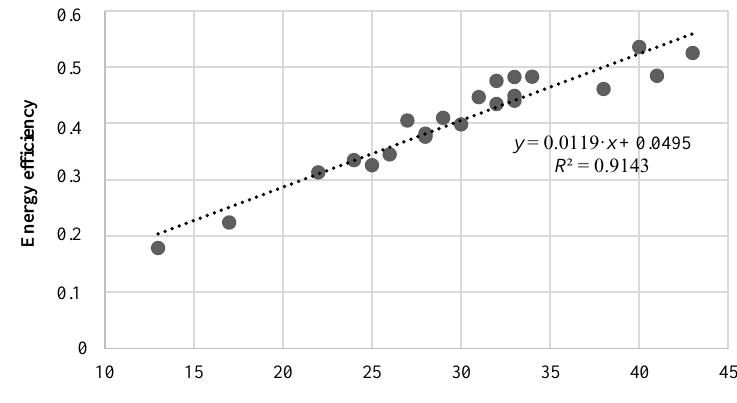
Fig. 8. Two-stage compressor refrigeration system exergy efficiency depending on ambient temperature and refrigerator temperature